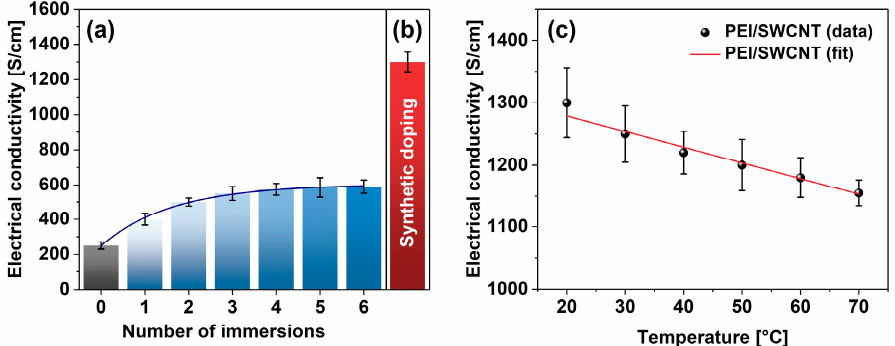
Figure 4. Comparison of the impact of PEI addition on electrical conductivity by ( a ) consecutive immersion and ( b ) synthetic doping. ( c ) Electrical conductivity of PEI-doped SWCNT films as a function of temperature.